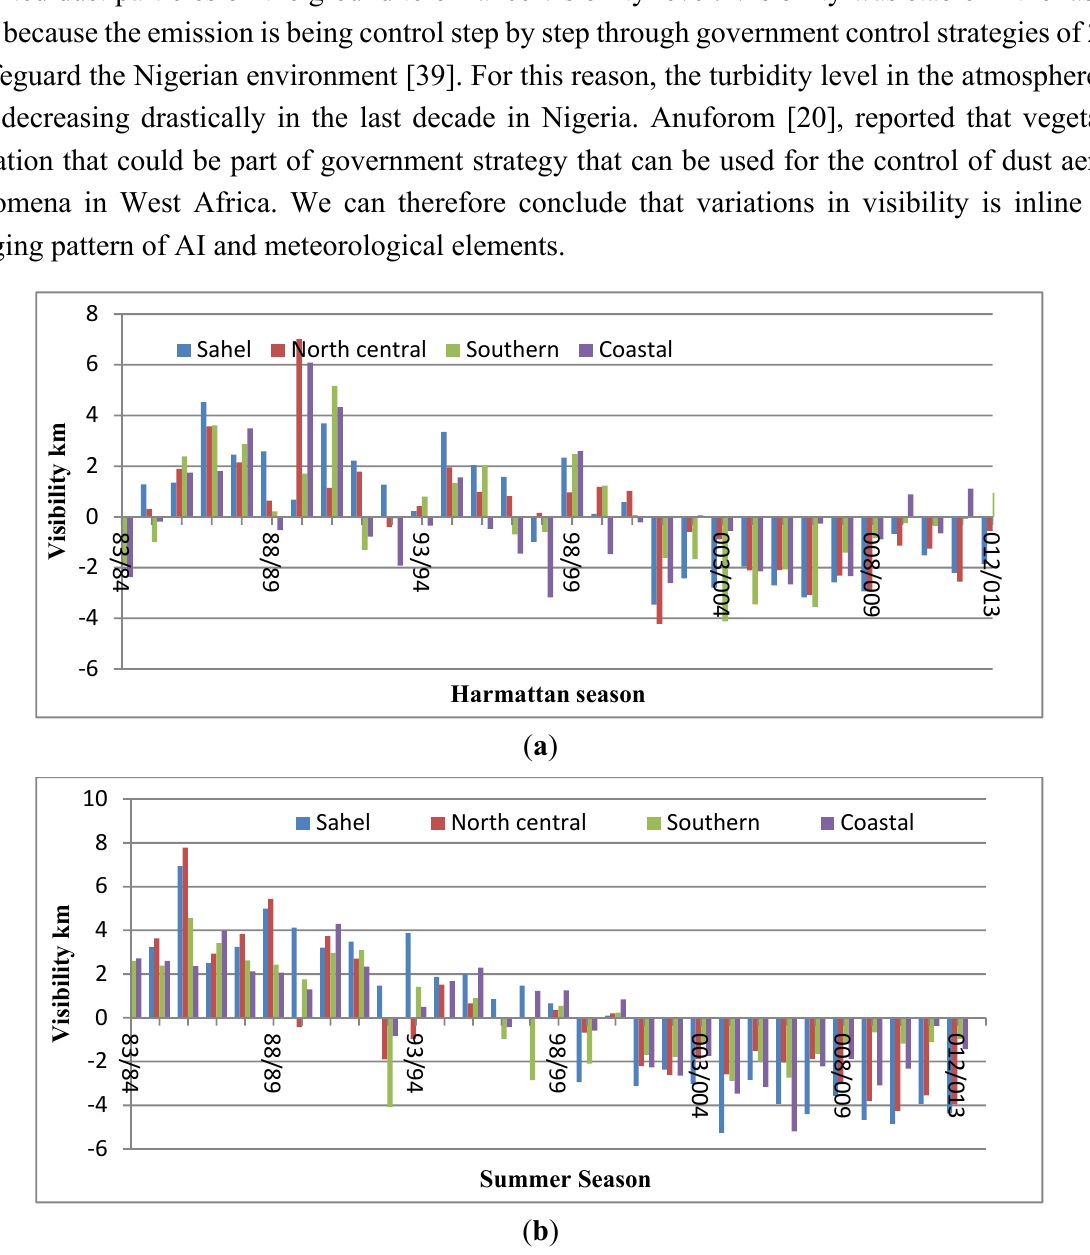
Figure 6. Comparism between ( a ) Harmattan and ( b ) summer season mean visibility anomaly among different zones of Nigeria from 1984 to